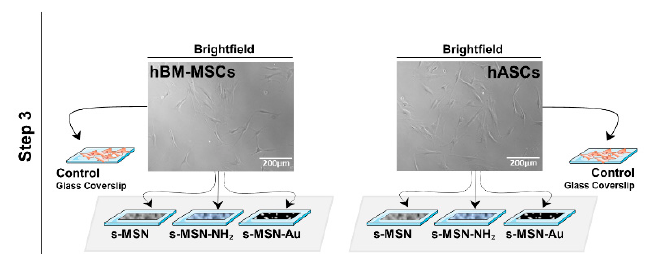
Figure 3. Schematic of the preparation of the homogeneous deposition of s-MSN, s-MSN-NH 2 , and s-MSN-Au on glass coverslips. Dropwise deposition of NPs on glass coverslips (step 1); drying of NPs deposition in a sterile laminar flow hood for 24 h (step 2); seeding of human Bone Marrow– Mesenchymal stem cells (hBM-MSCs) and Adipose stem cells (hASCs) on nanoparticles (NPs) deposition (step 3). Brightfield representative images of NPs deposition after 24 h of its preparation on glass coverslip and brightfield representative images of hASCs and hBM-MSCs used for the study and before the plating on NPs. Scale bar = 200 µm.